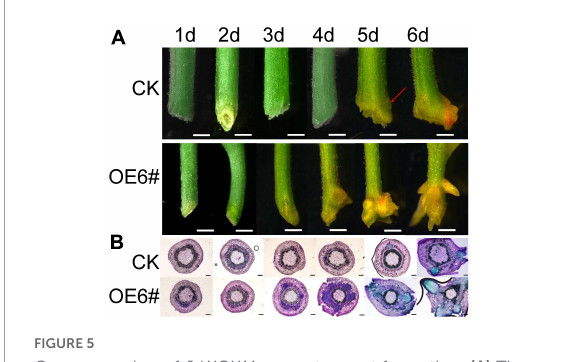
FIGURE5 Overexpression of JrWOX11 promotes root formation. (A) The phenotype investigation of the poplar stem base during rooting 1–6 days. Bar = 1 mm. (B) The histological investigation of the poplar stem base during rooting 1–6 days. Bar = 200 µ